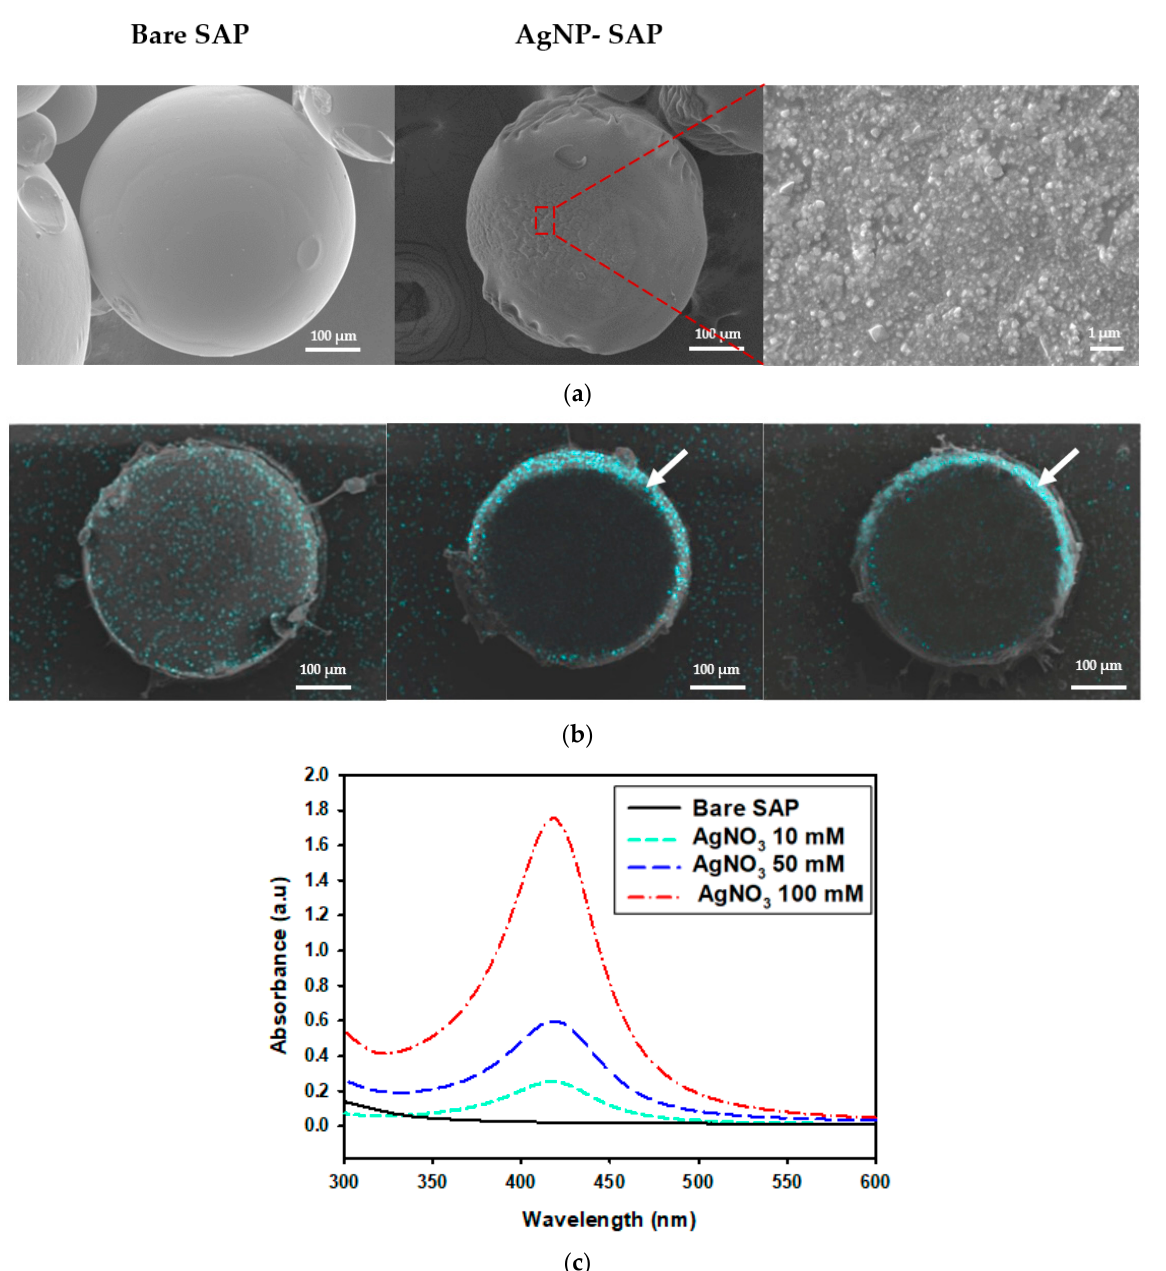
Figure 1. Characterization of different SAP spheres. ( a ) SEM images of the surface of bare SAP and AgNP-SAP prepared from 50 mM AgNO 3 . ( b ) EDS mapping images for silver element obtained from cross-section of AgNP-SAP (sky blue that arrows indicate is the layer of AgNPs). ( c ) UV-Vis spectra of AgNP-SAP prepared from different concentration of AgNO 3 .